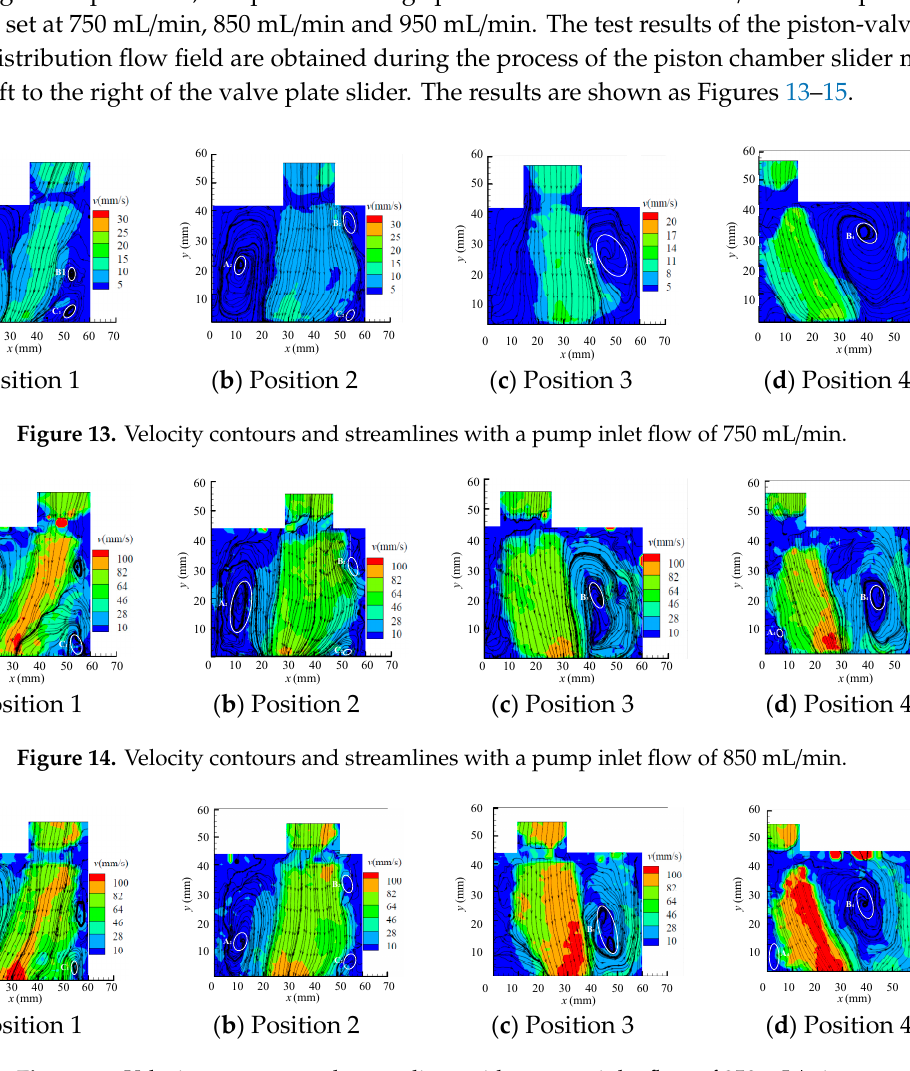
Figure 15. Velocity contours and streamlines with a pump inlet flow of 950 mL/min.